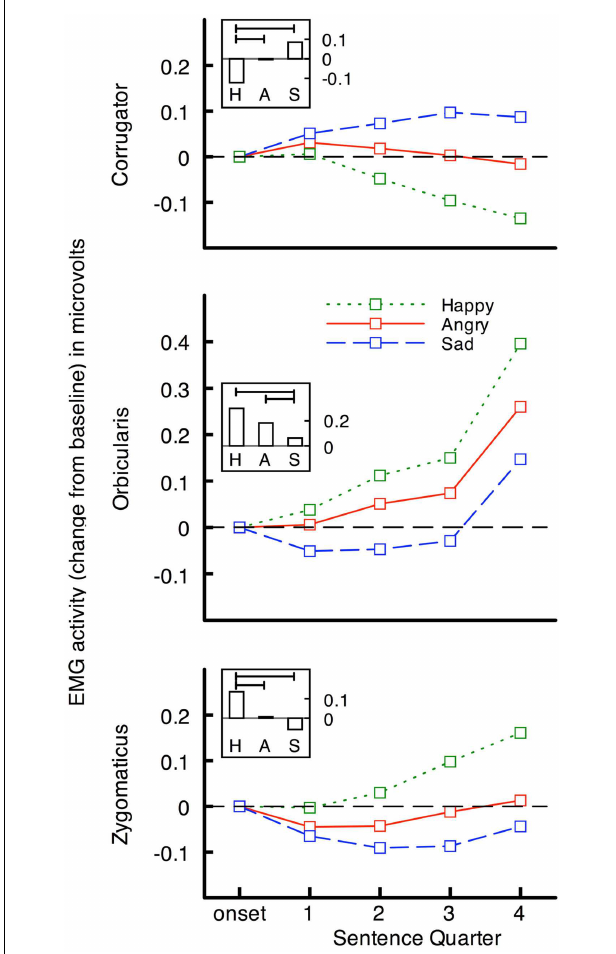
FIGURE 1 | Facial EMG change in microvolts from baseline (1000 ms before sentence onset) for emotional sentences across sentence quarters, and overall (inset; vertical bars represent mean EMG change during sentence presentation, and horizontal bars indicate significant comparisons) from Havas et al., 2010. Activity in muscles for frowning (corrugator) and smiling (orbicularis and zygomaticus) diverges rapidly after onset of happy, angry, and sad, sentences.The fourth sentence quarter corresponds to participants’ pressing of a button to indicate they understood the sentence. Sentence presentation durations have been